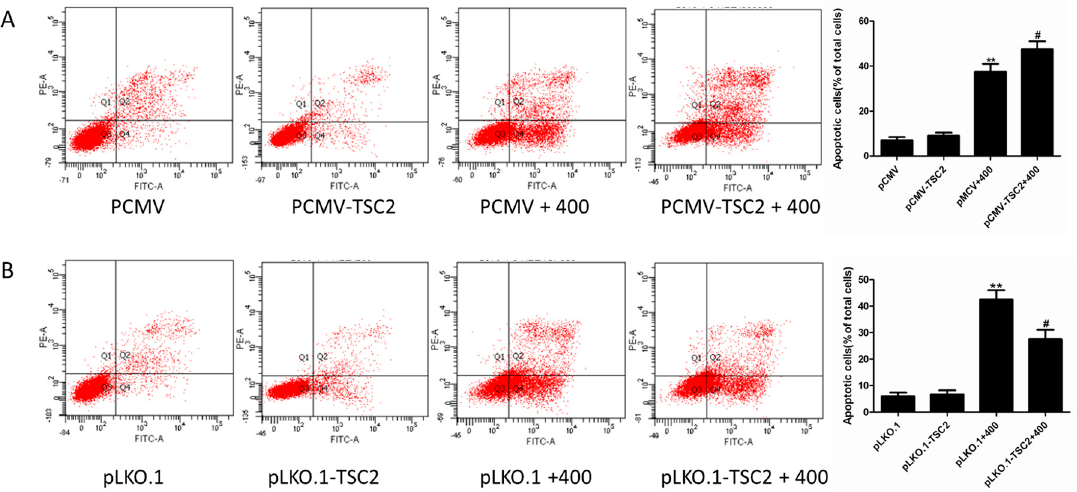
Figure 7. Effect of TSC2 on olaquindox-induced apoptosis. ( A ) Increased of olaquindox-induced apoptosis by overexpressed TSC2 in 293 cells was estimated by flow cytometry with Annexin V-FITC/PI staining ( B ) Reduced of olaquindox-induced apoptosis by knockdown of TSC2 in 293 cells was estimated by flow cytometry with Annexin V-FITC/PI staining. All data represents means ± SD from three independent experiments. ** p < 0.01, compared to the control pCMV or pLKO.1 transfected cells; # p < 0.05, compared to olaquindox-treated pCMV or pLKO.1 transfected cells.